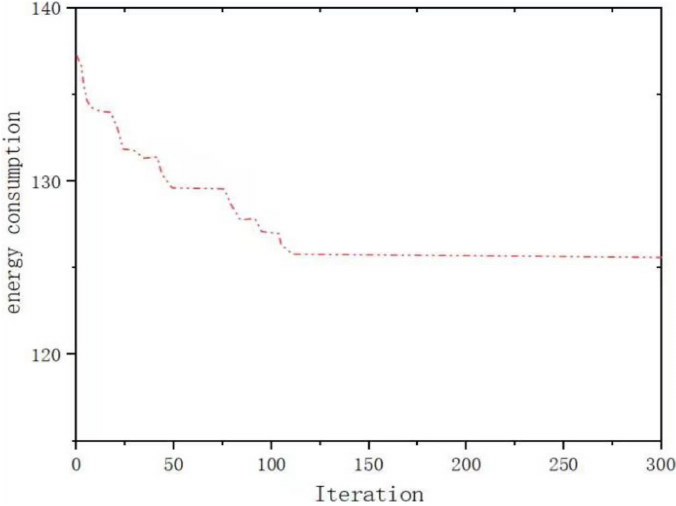
Figure 6. Energy consumption iterative convergence graph for blank dimension